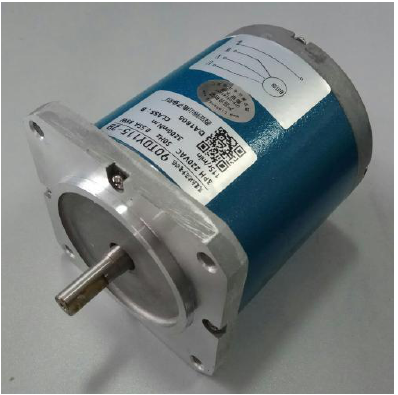
Figure 4. The 90TDY115-2B permanent magnet low speed synchronous motor.